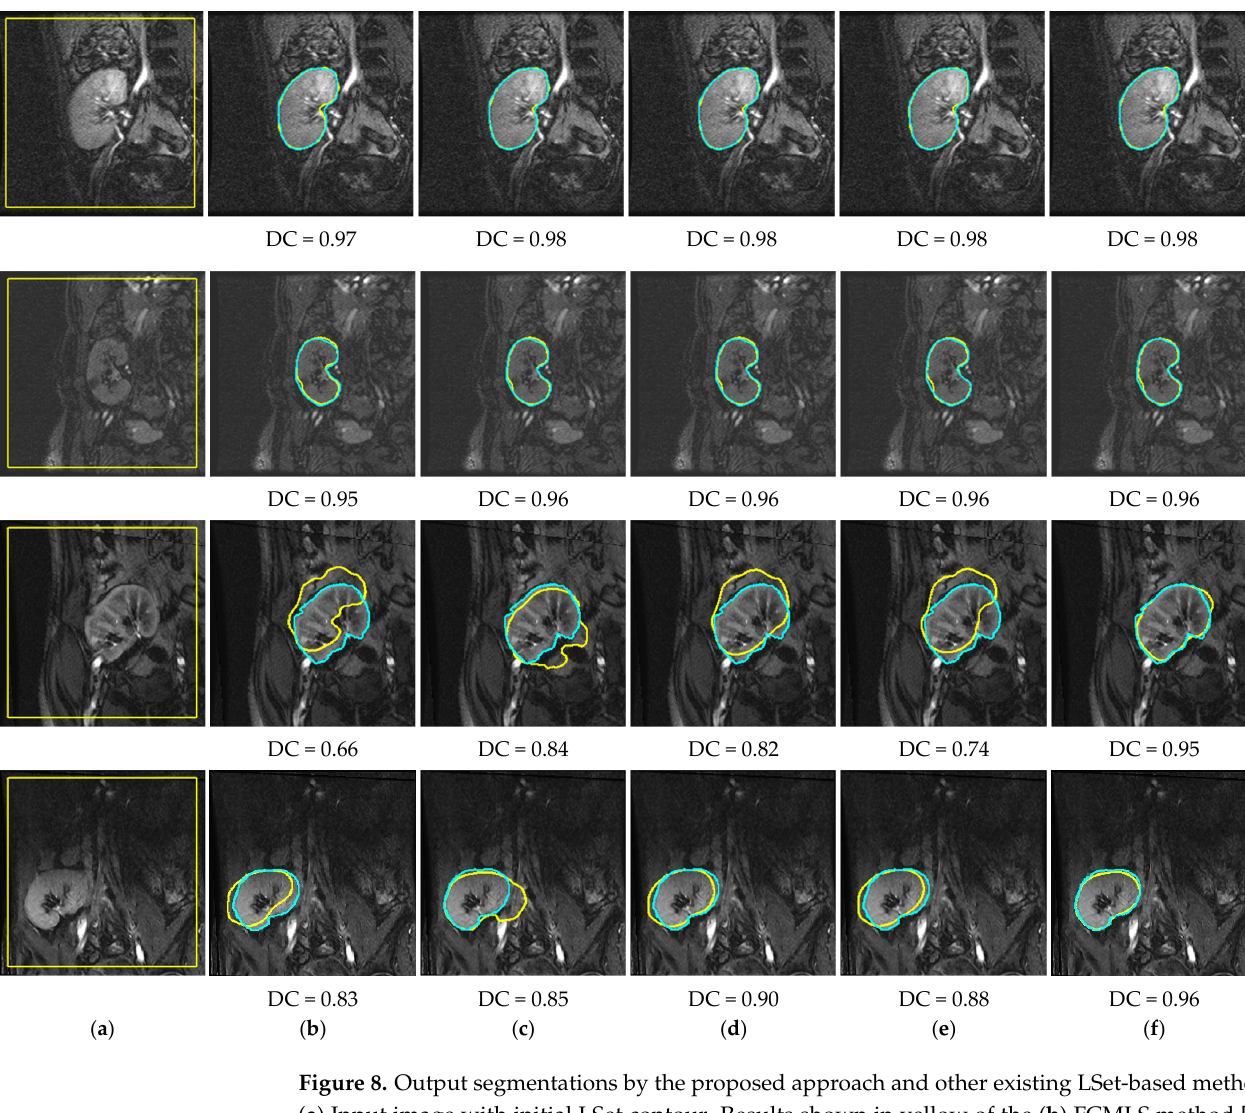
( c ) PBPSFL method [12], ( d ) PSFL method [13], ( e ) FML method [17], and the ( f ) proposed approach. proach. Ground-truth segmentation was imposed on each image in cyan along with the corre-